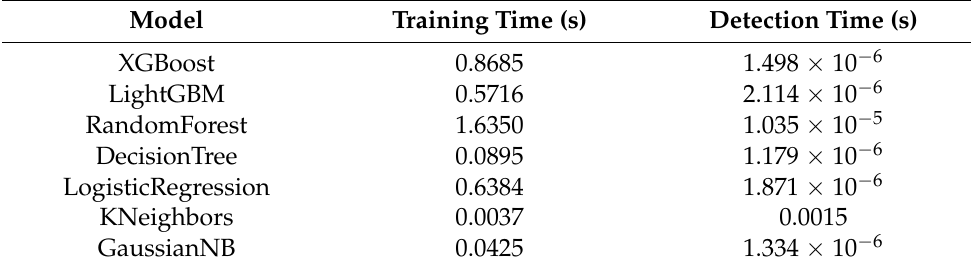
Table 6. Training and detection